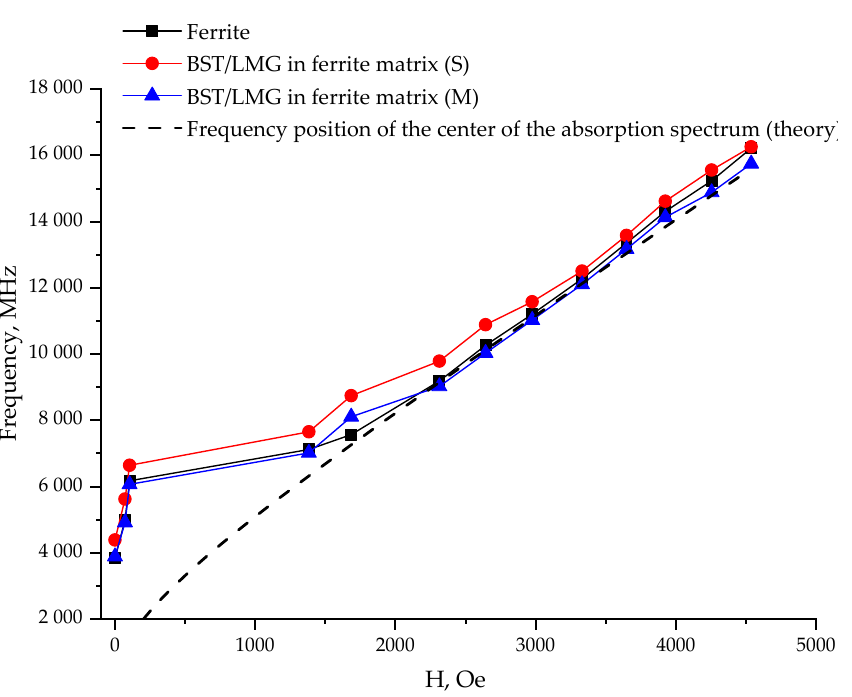
Figure 7. Frequency position of the center of the absorption spectrum of samples depending on the magnitude of the magnetization field. magnitude of the magnetization